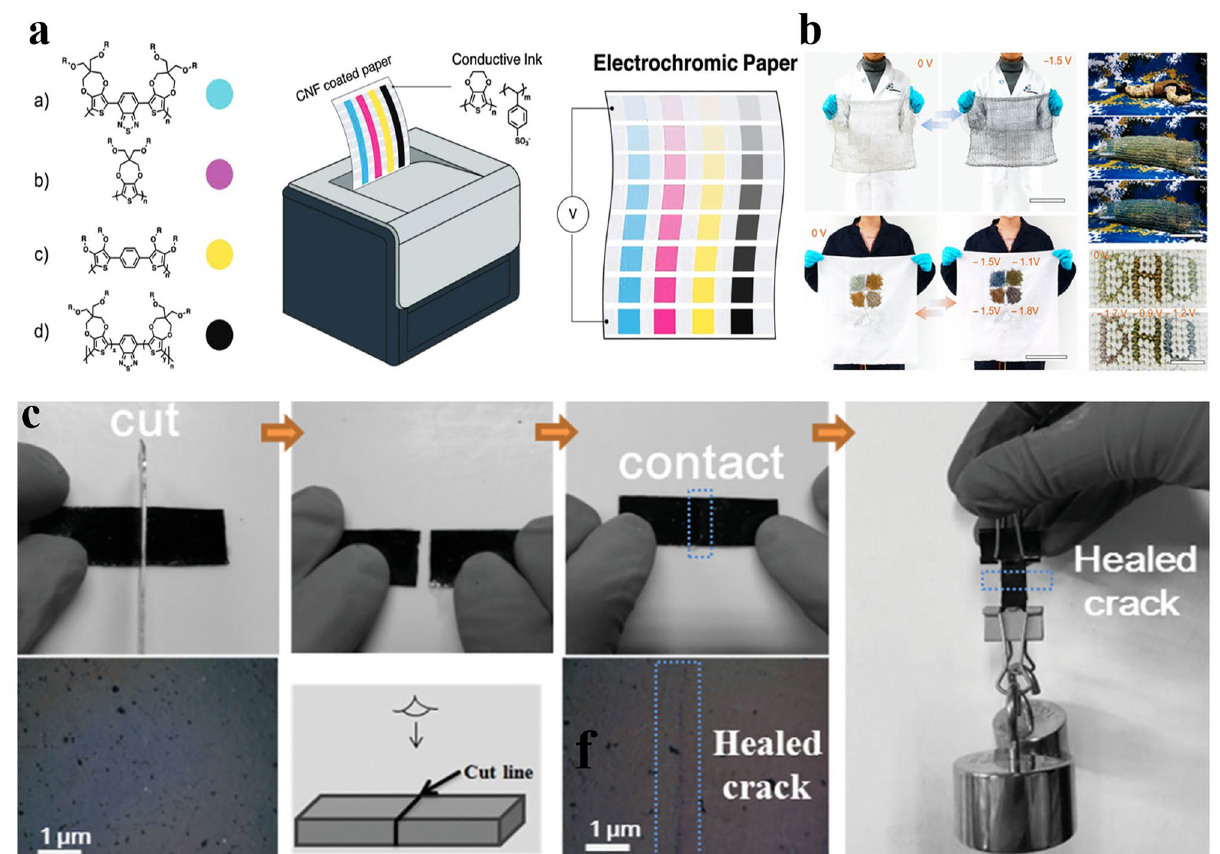
Fig. 9 Progress of conducting substrates in MERABs. a Electrochromic paper-based displays. Reproduced with permission [114]. Copyright 2019, Wiley–VCH. b Anti-camouflage clothing. Reproduced with permission [115]. Copyright 2020, American Chemical Society. c Digital photo of the self-reparability of reinforced self-healed polymer and the corresponding SEM images of the surface of reinforced self-healed poly- mer. Reproduced with permission [116]. Copyright 2019,